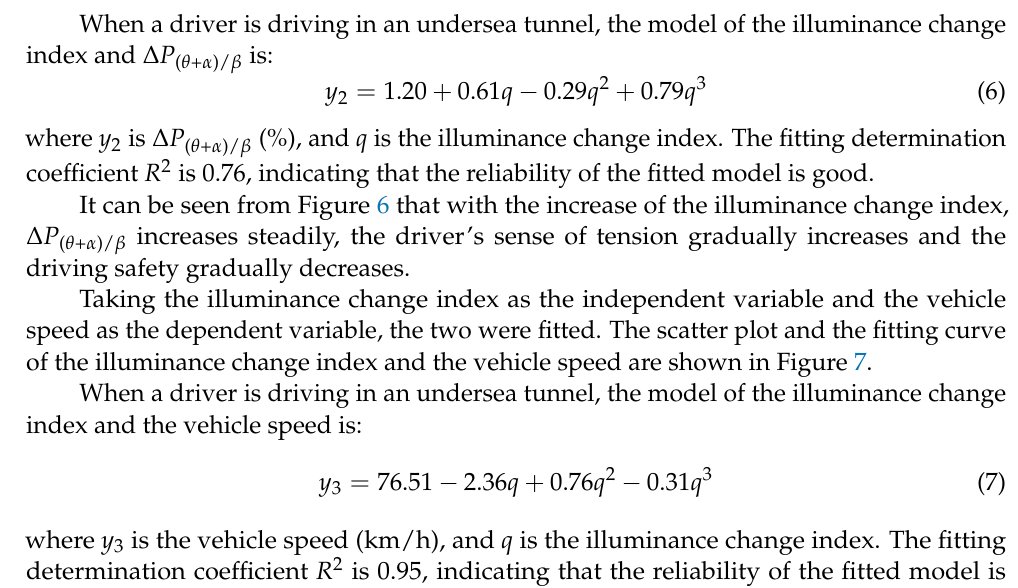
Figure 7. Fitting curve of illuminance change index and vehicle speed. When a driver is driving in an undersea tunnel, the model of the illuminance change index and the vehicle speed is: